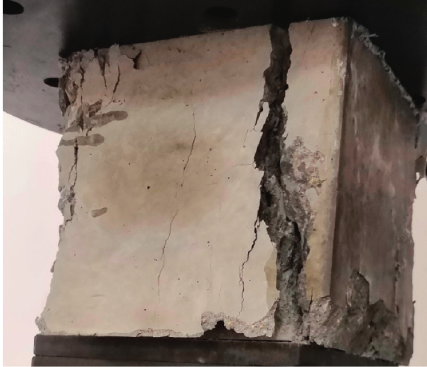
Figure 4: Macroscopic cracks on the outer surface of the